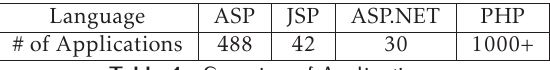
Table 1. Grouping of Applications